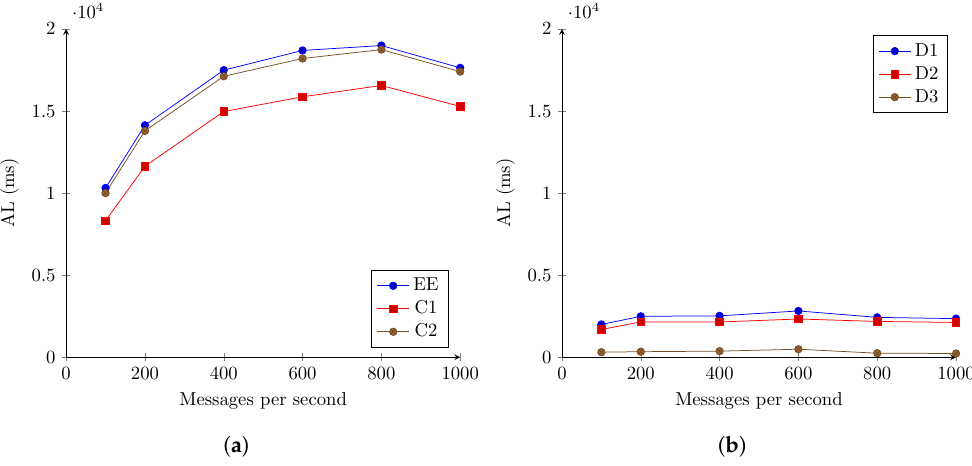
Figure 6. AL registered for the second stage evaluation. LoRaWAN for 1 simulated device. ( a ) Registered latencies for monitored components and end to end. ( b ) Differences in recorded latencies between components.